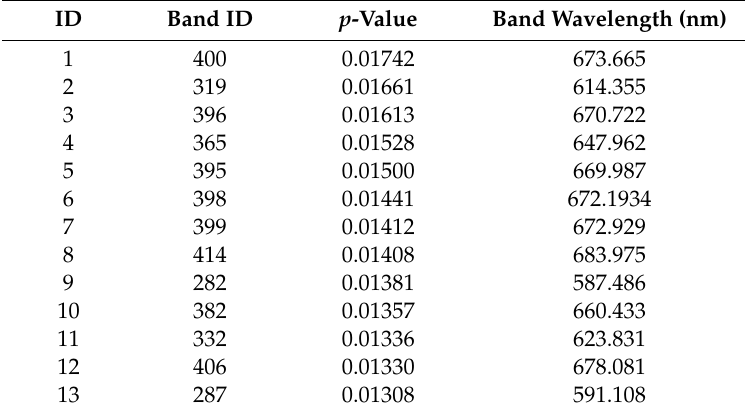
Figure 3. ( a ) Original tilting image; ( b ) p -value distribution map. Table 2. Information of selected bands.